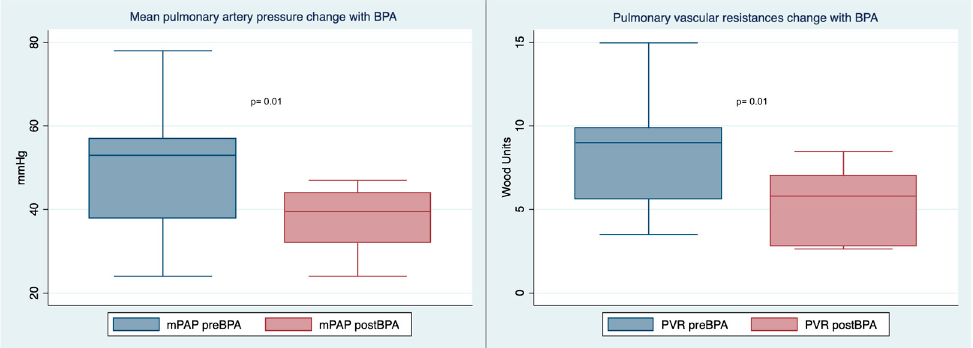
Figure 2. Box plot with mPAP ( left ) and PVR ( right ) changes after BPA. (BPA: balloon pulmonary angioplasty; mPAP: mean pulmonary artery pressure; PVR: pulmonary vascular resistance).